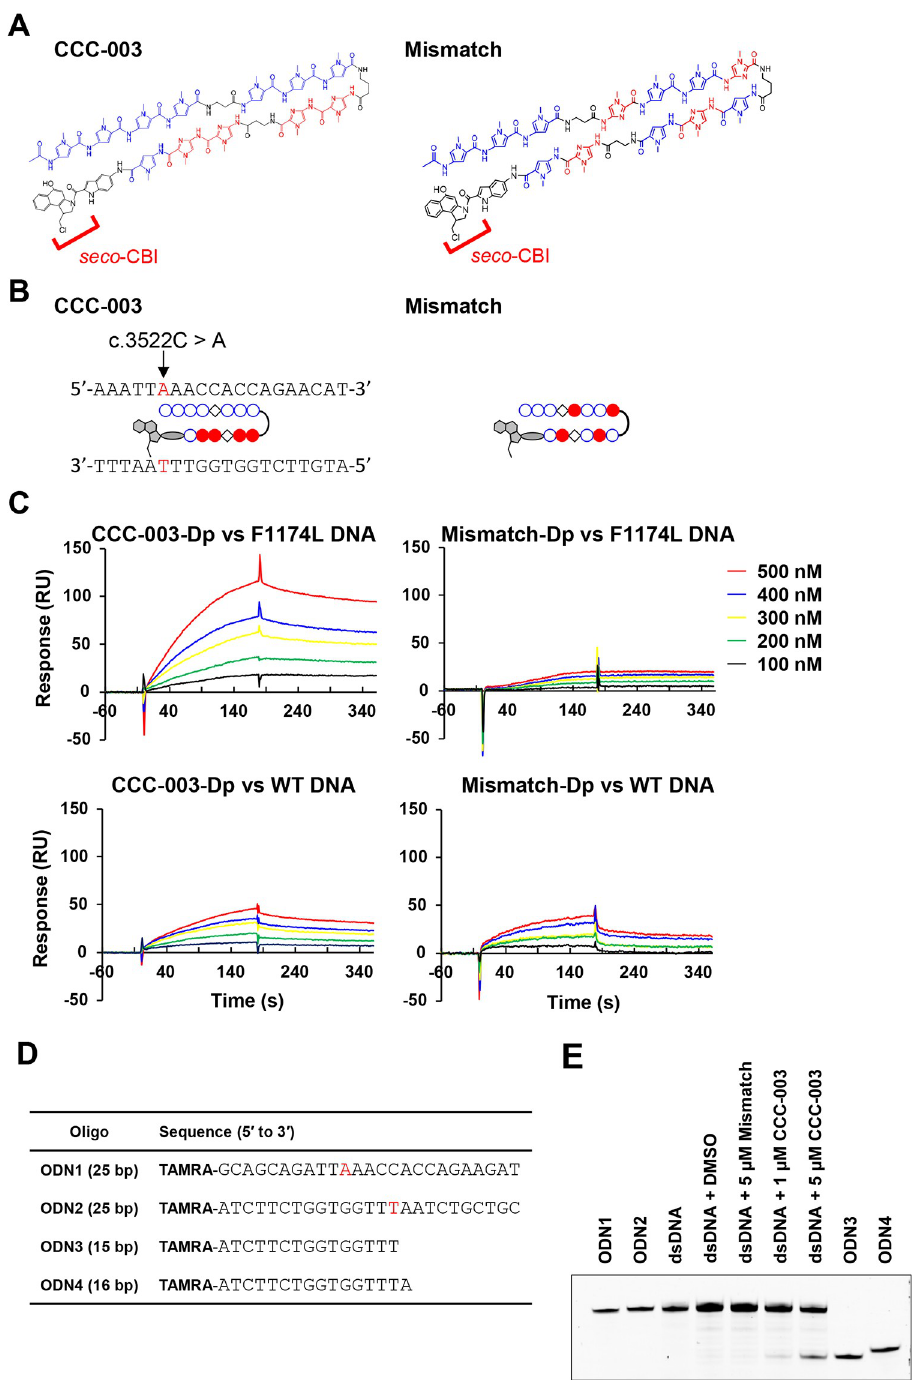
Fig 1. CCC-003 specifically recognizes the DNA sequence of mutant ALK . (A) Chemical structure of CCC-003, a sequence-specific DNA-alkylating agent directly targeting the F1174L-mutated ALK gene, and the mismatch polyamide (Mismatch), which had no binding motif within the coding region of the ALK gene. The site of alkylation is shown in red. (B) Schematic drawing of CCC-003 and Mismatch at the site of ALK F1174L mutation. Blue open circles represent pyrrole moieties and red circles represent imidazole. Arrow indicates the position of the ALK F1174L mutation. (C) SPR sensorgrams for the interaction of CCC-003-Dp with hairpin DNAs containing the F1174L mutation sequence, Mismatch-Dp with hairpin DNAs containing the F1174L mutation sequence, CCC-003-Dp with hairpin DNAs containing the wild-type sequence, and Mismatch-Dp with hairpin DNAs containing the wild-type